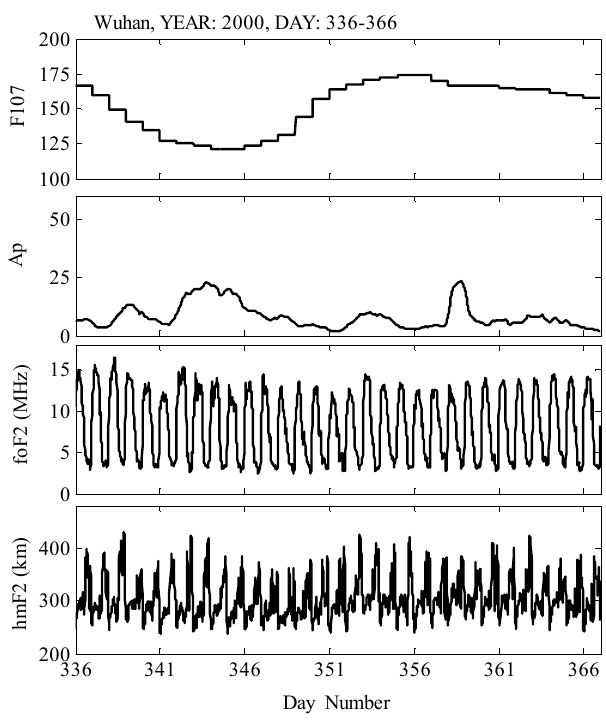
Fig. 6. Same as Fig. 4 but for days 336-366 (December 1-31), 2000.